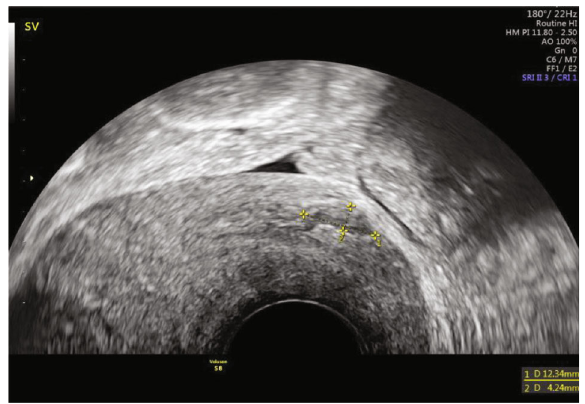
Figure 7: Transvaginal ultrasonographic study of the pelvic- abdominal region showed a retroverted uterus, with a biometry of 66mm x 33mm. Images of cavitary pathology were not observed. The endometrial thickness was 4mm.